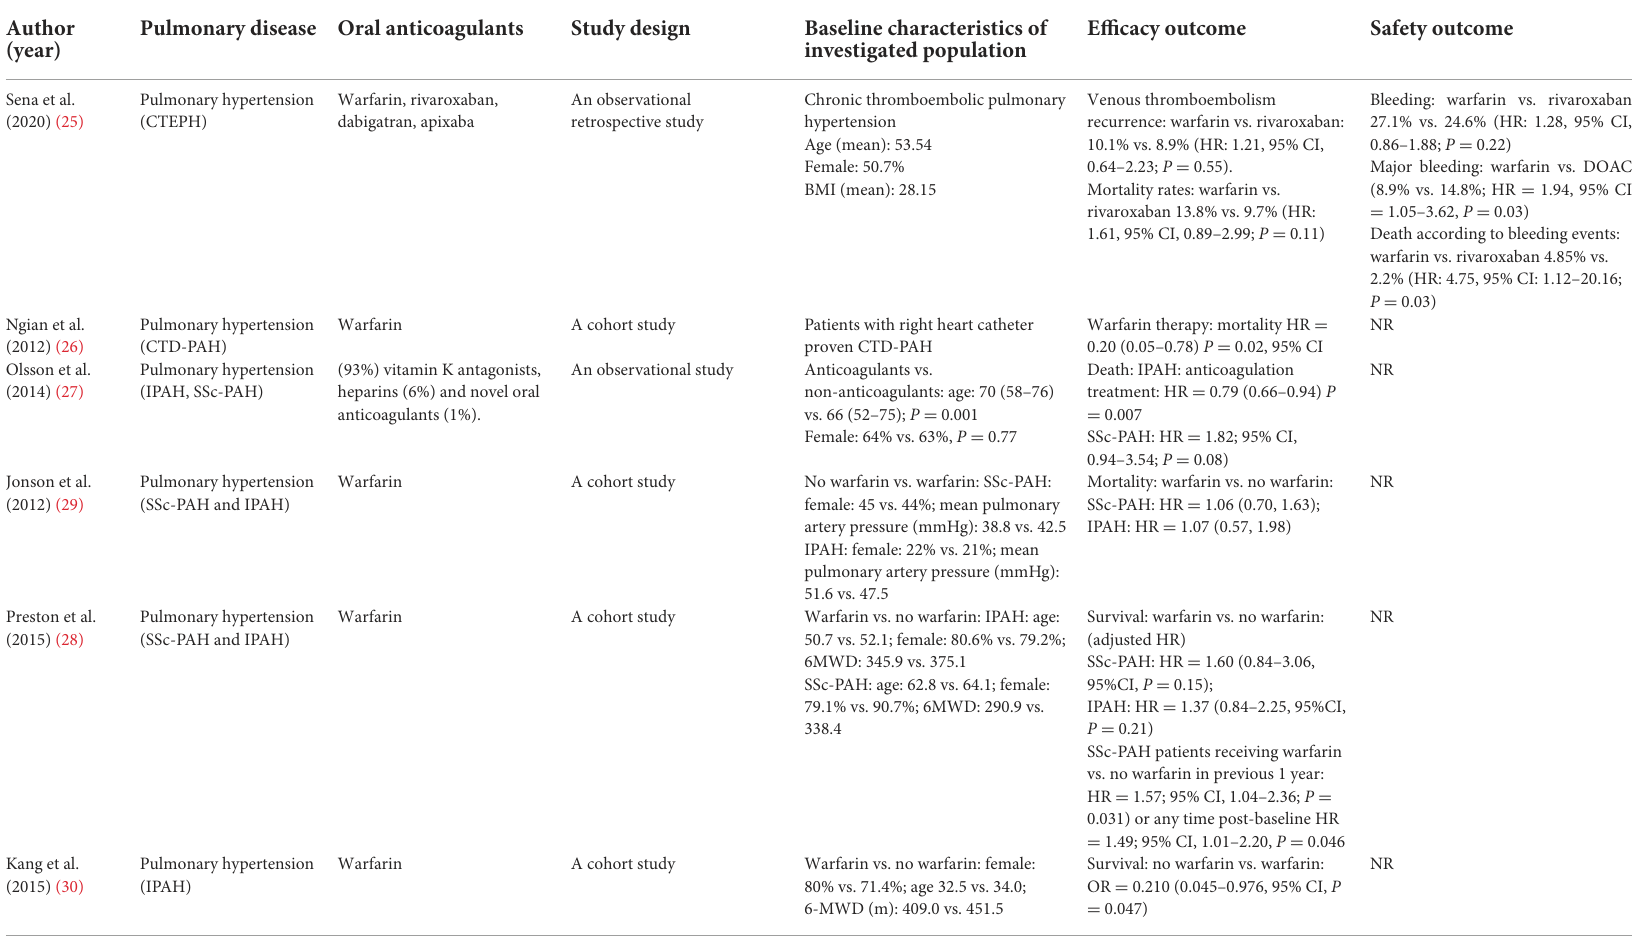
TABLE 1 Summary of included studies of OACs in patients with pulmonary